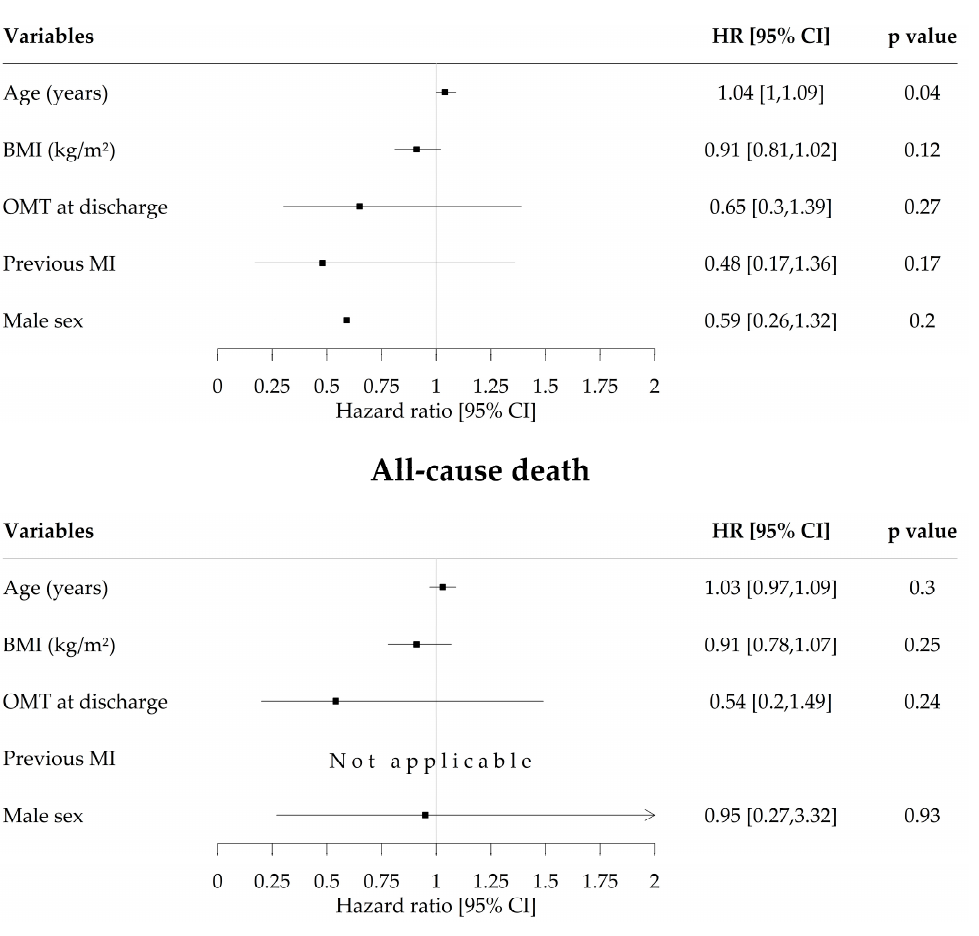
Figure 5. Univariate Cox regression analysis in ISCHEMIA-eligible Patients. Primary outcome was a composite of death from cardiovascular cause and the new onset acute coronary syndrome. Optimal medical therapy was defined as a prescription of aspirin, P2Y12 inhibitors, and statins after PCI.